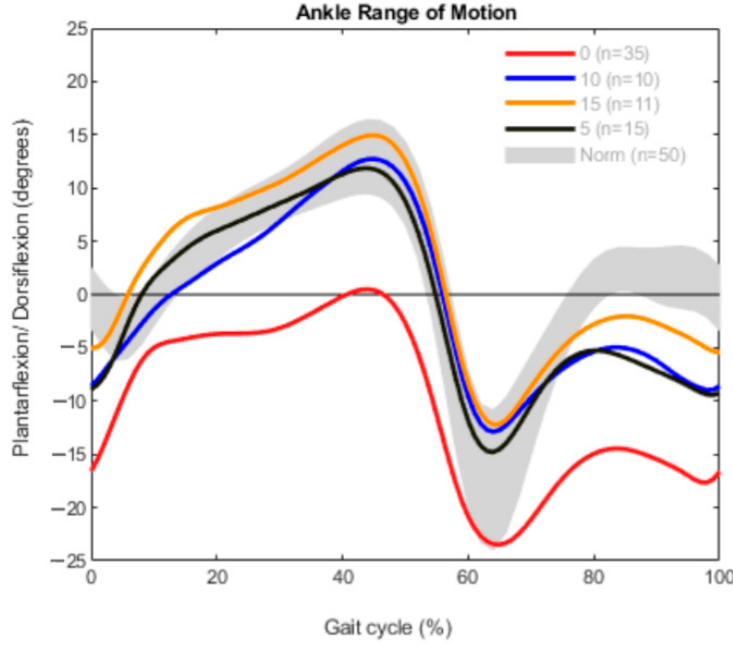
Figure 4. Range of motion measurement in the unilateral group ( n = 71).